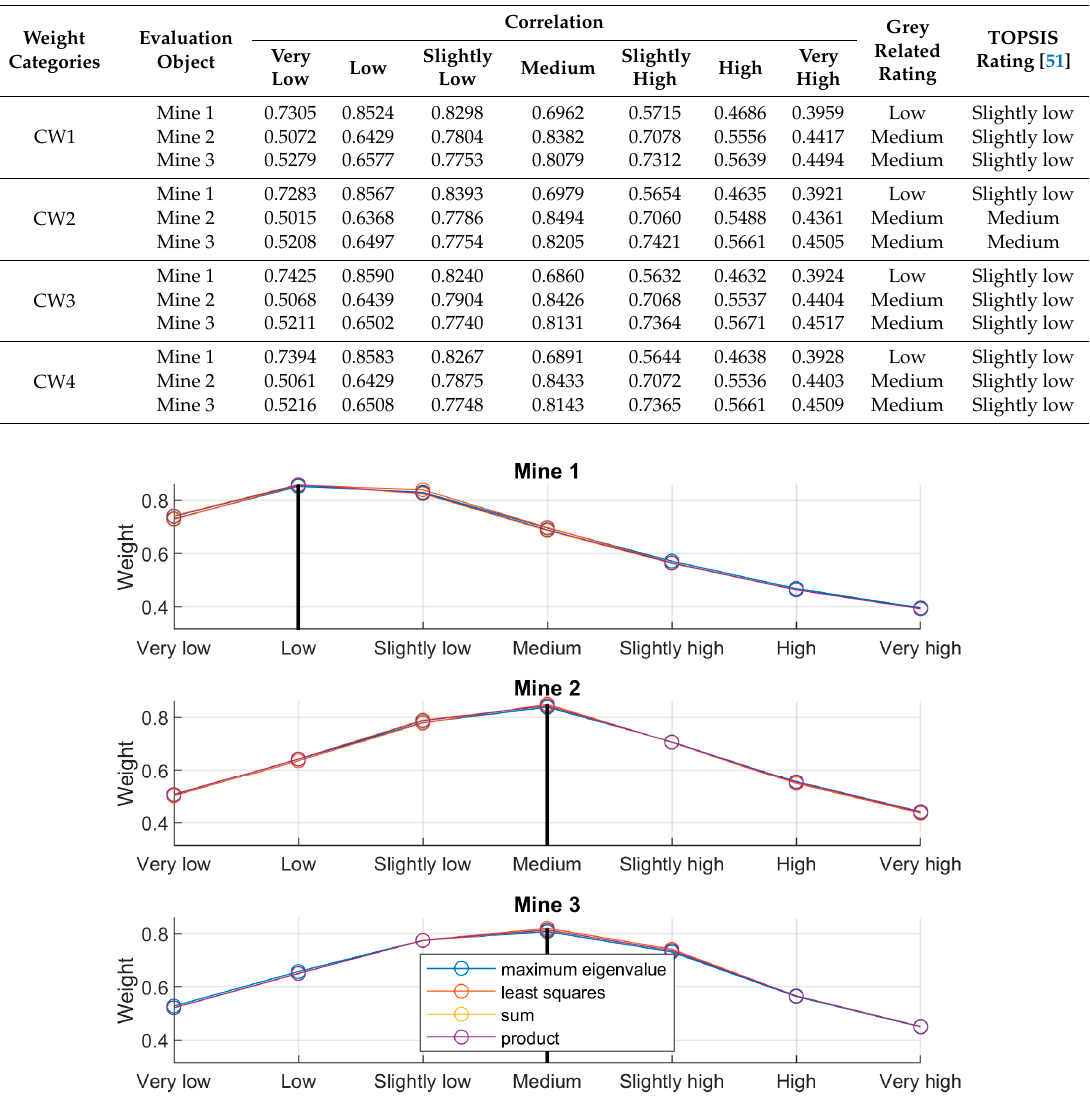
Table 5. Fuzzy-grey correlation risk rating based on the cautious attitude.